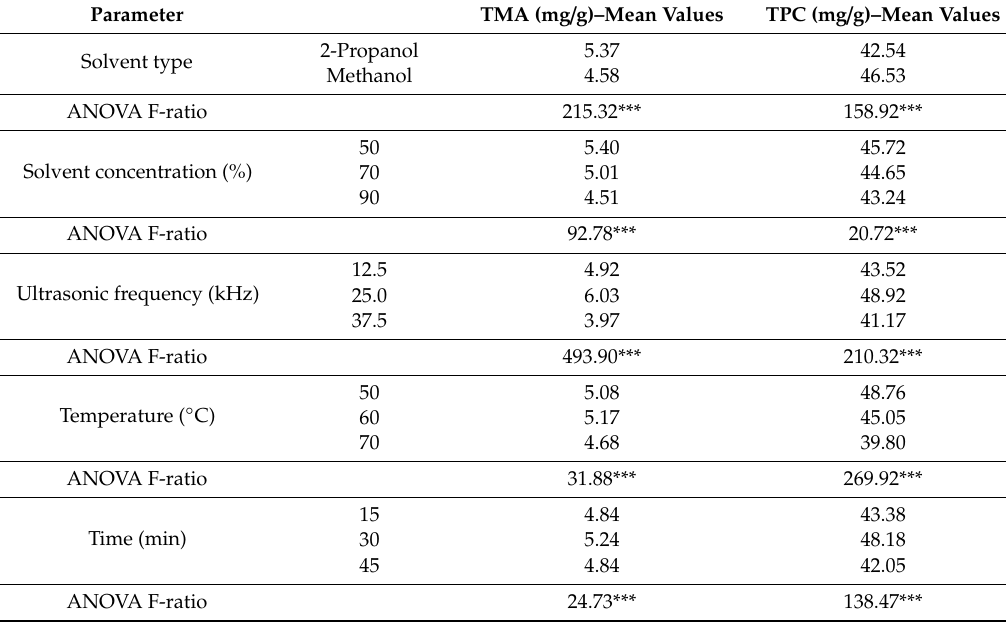
Table 2. Analysis of variance of TMA and TPC as functions of ultrasonic frequency, solvent type, concentrations, temperatures and